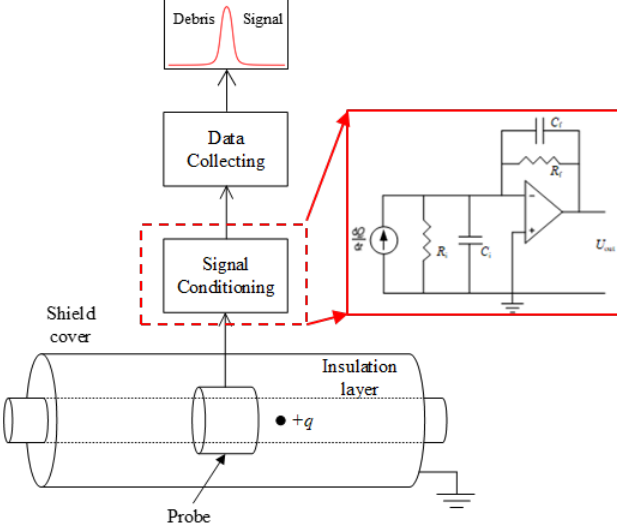
Figure 1. The physical structure and the data acquisition system block diagram of an oil-line electrostatic sensor (OLES).